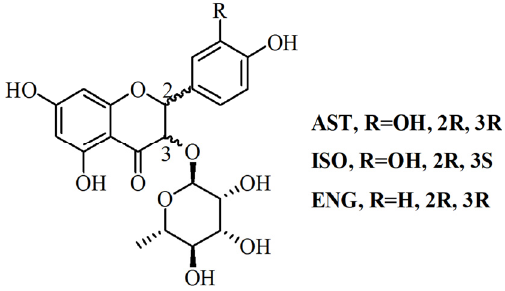
Figure 1. The structure of AST ISO and ENG.